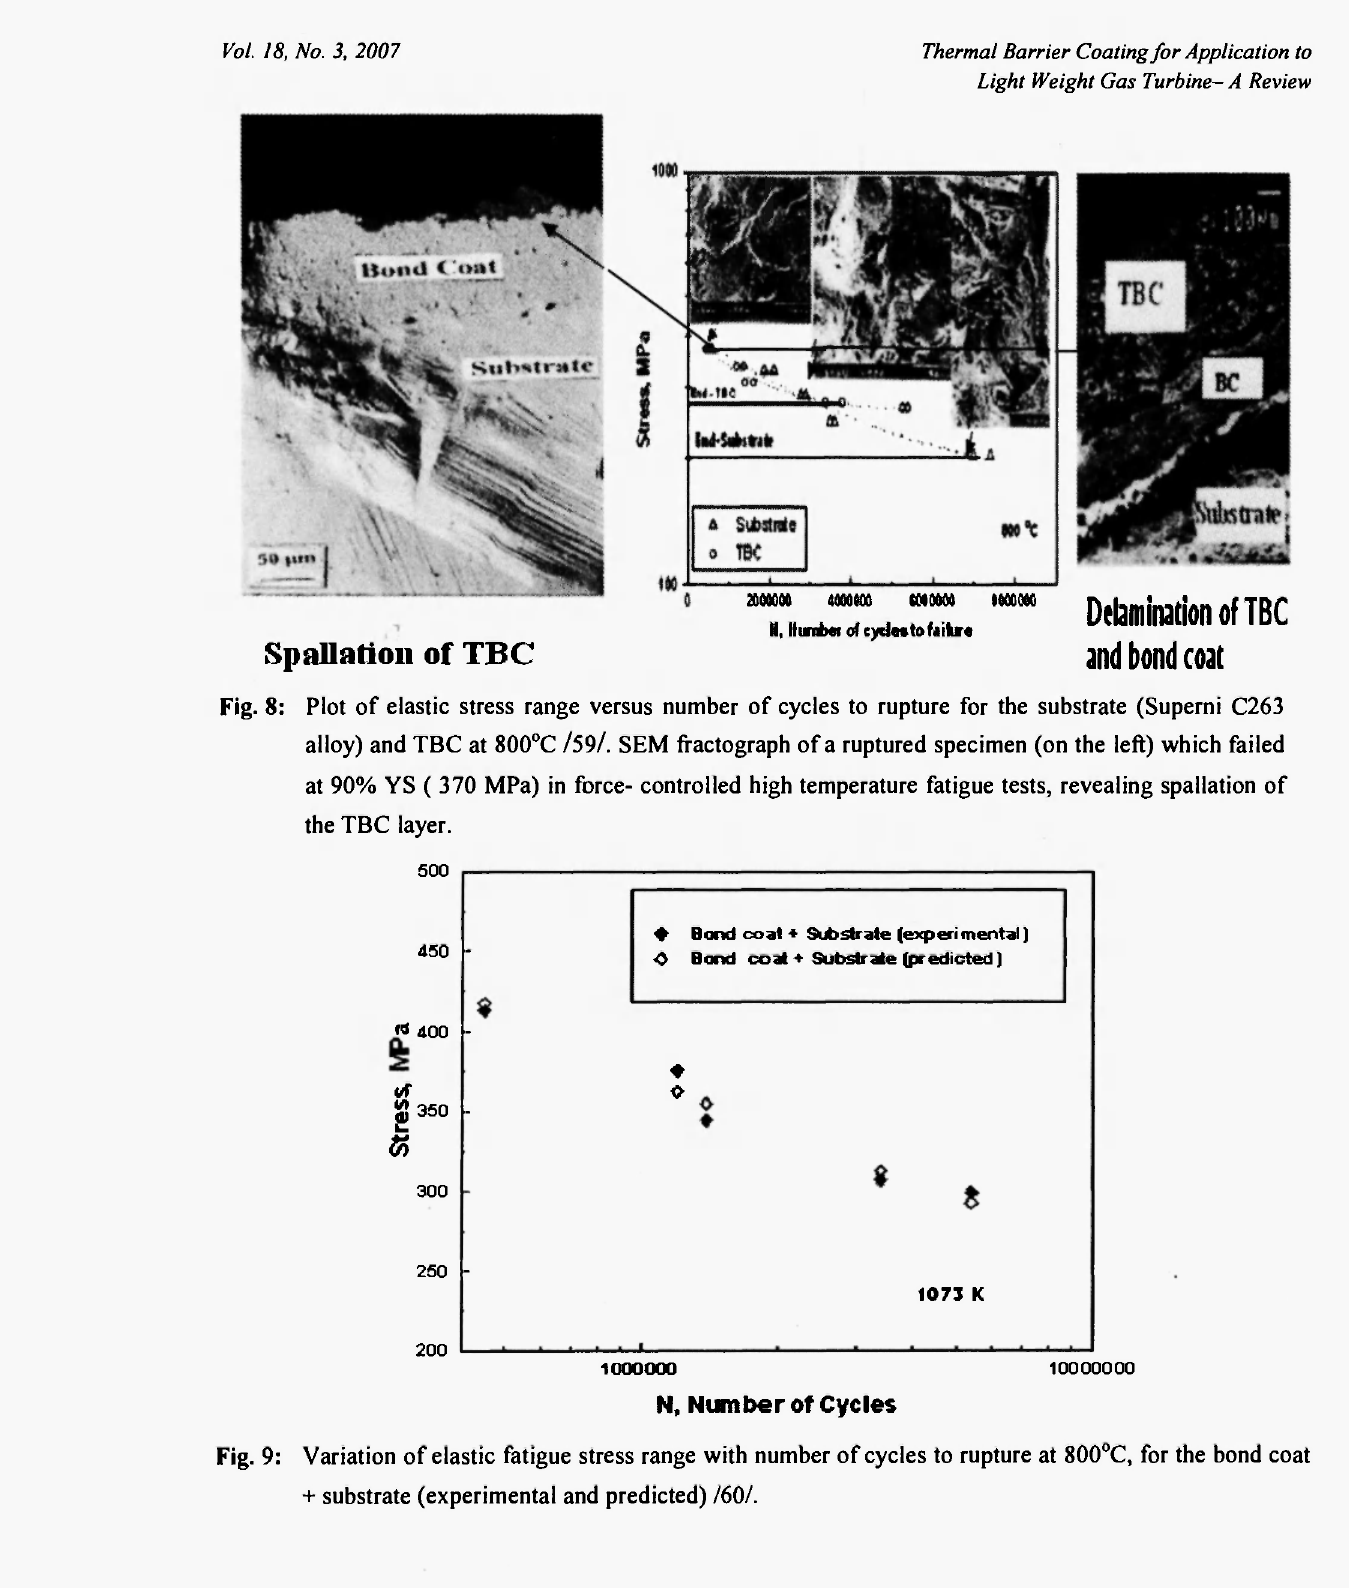
Fig. 9: Variation of elastic fatigue stress range with number of cycles to rupture at 800°C, for the bond coat + substrate (experimental and predicted)